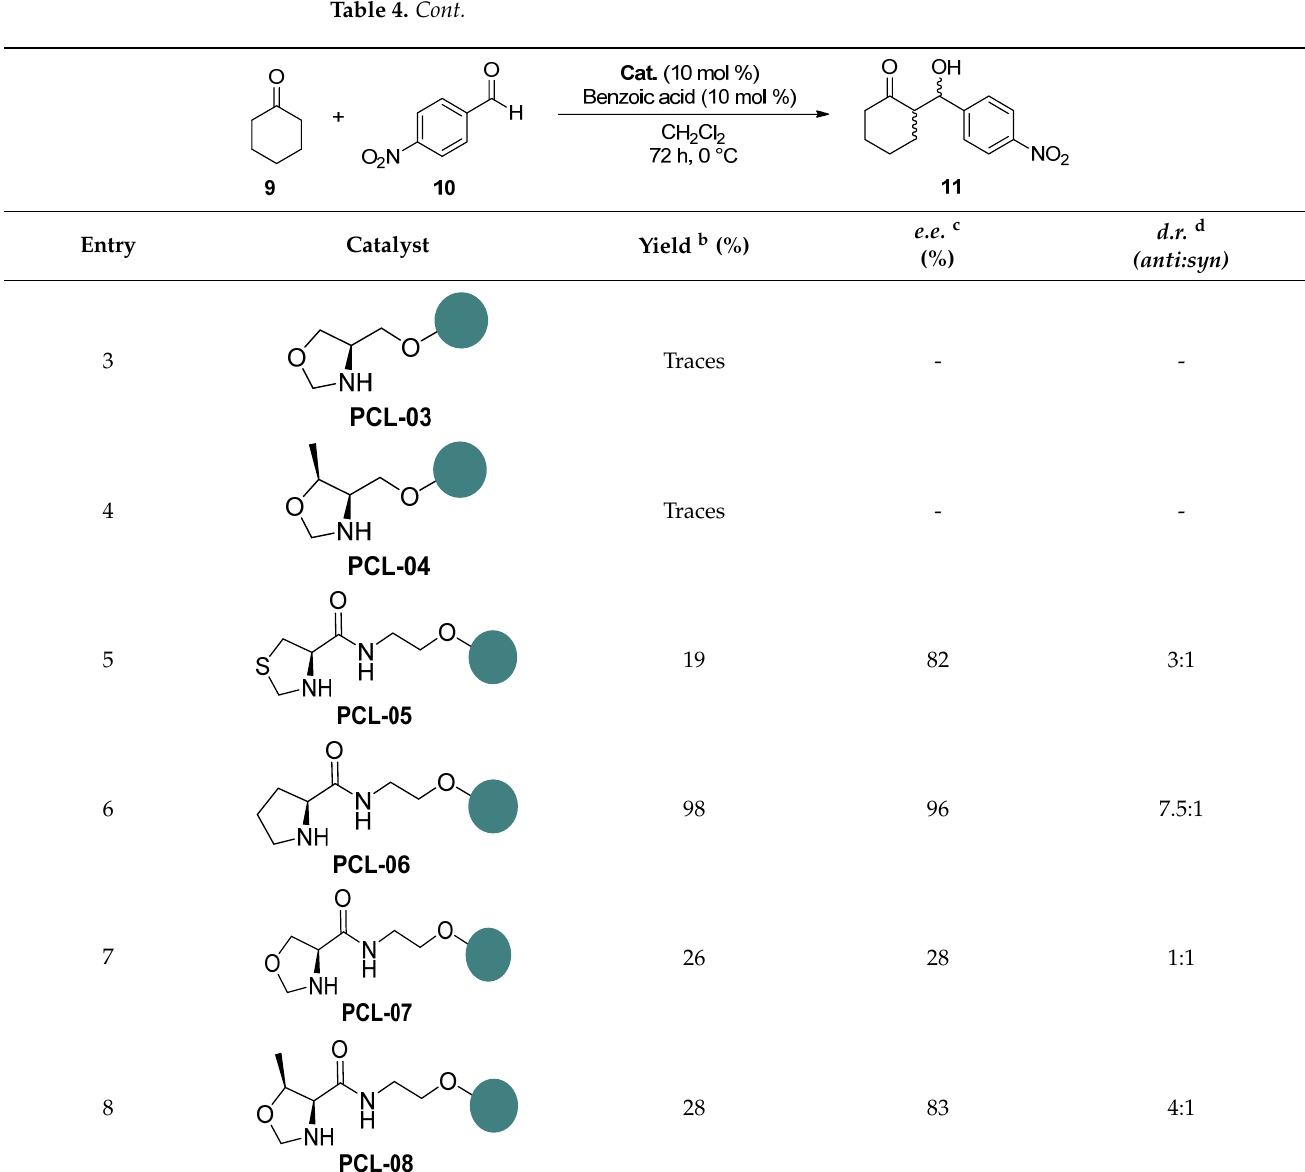
Table 4. Aldol addition reaction between cyclohexanone and p -nitrobenzaldehyde catalyzed by Table 4. Cont. supported compounds PCL-01 to PCL-08 a .